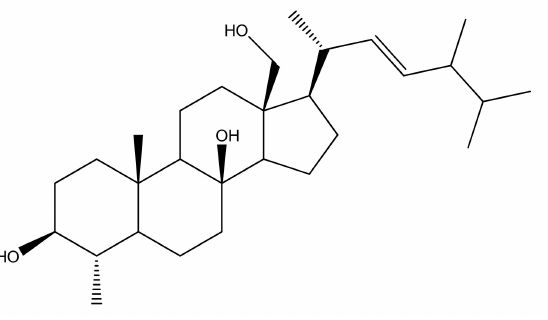
Figure 1. Chemical structure of 4 α ,24-dimethyl-5 α -cholest-8 β ,18-dihydroxy,22 E -en-3 β -ol ( ST-1